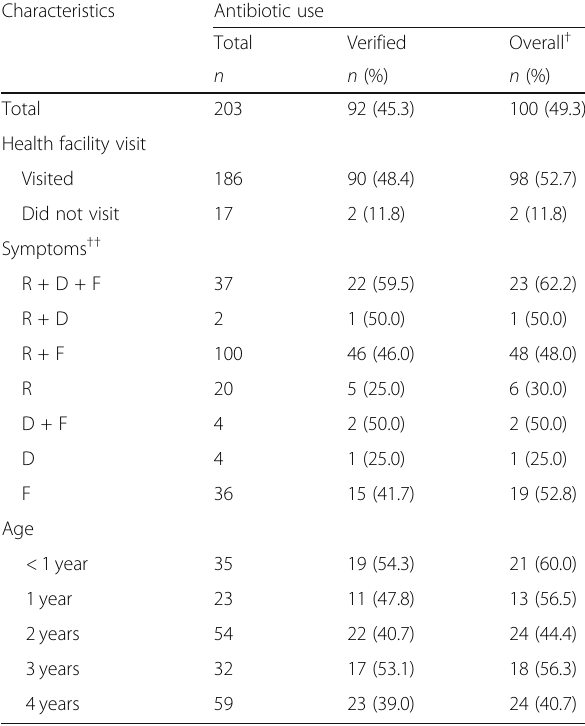
Table 1 Characteristics of the female caregivers and children Characteristics